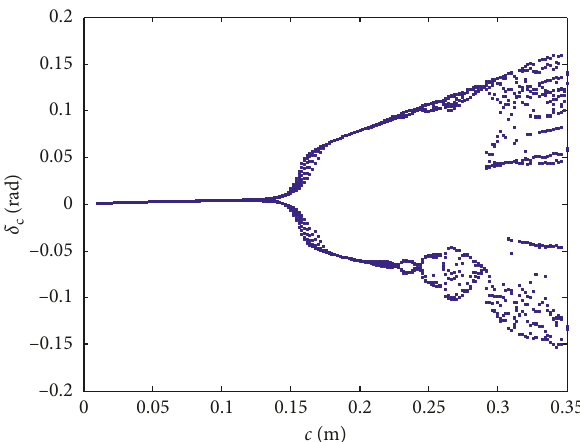
Figure 9: Effects of c on the compliance steering angle δ